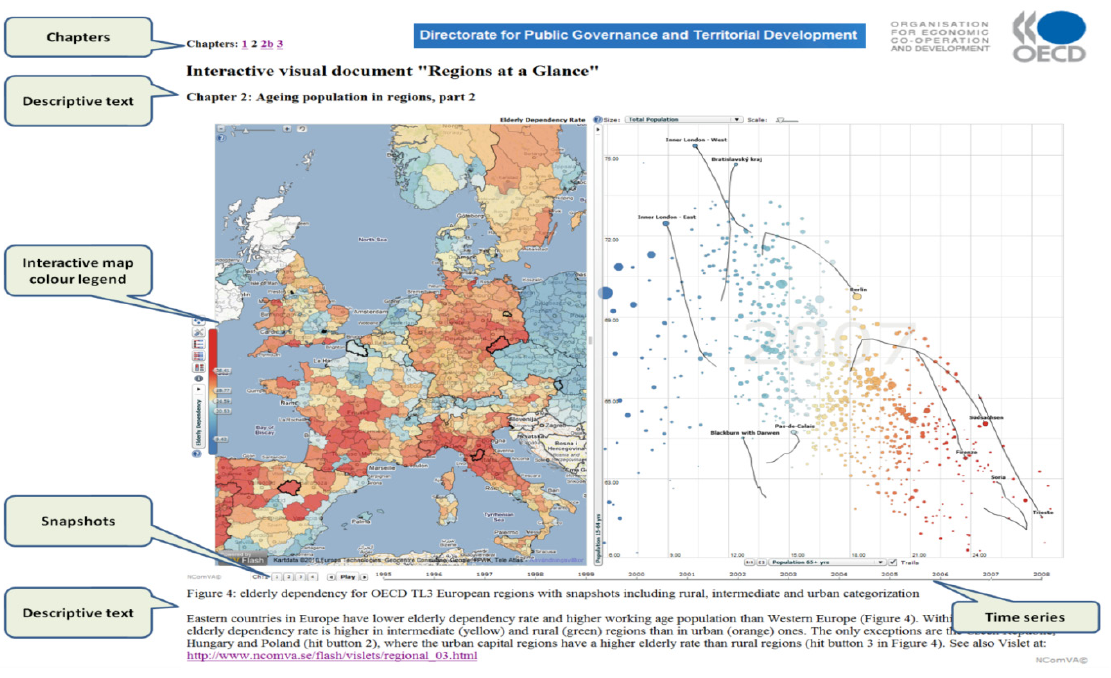
Figure 5. Example of an interactive educational document based on public Organization for Economic Co-operation and Development (OECD) data. The document includes an educational text, as well as a map, motion chart, snapshots and time series— i.e ., the methodological